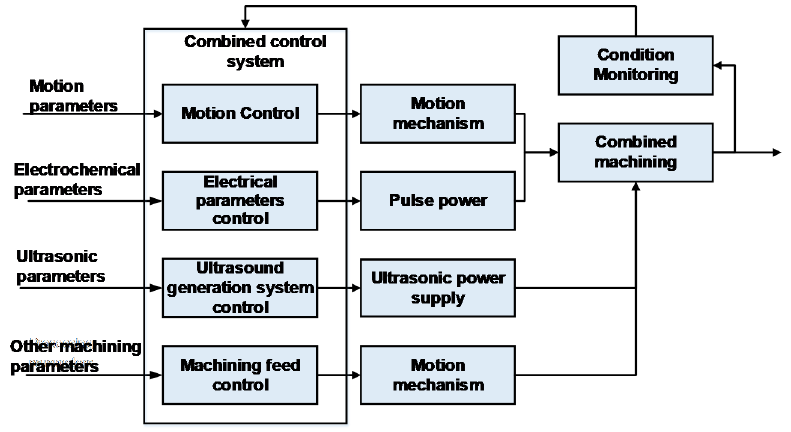
Figure 3. Functional block diagram of combined machining system.